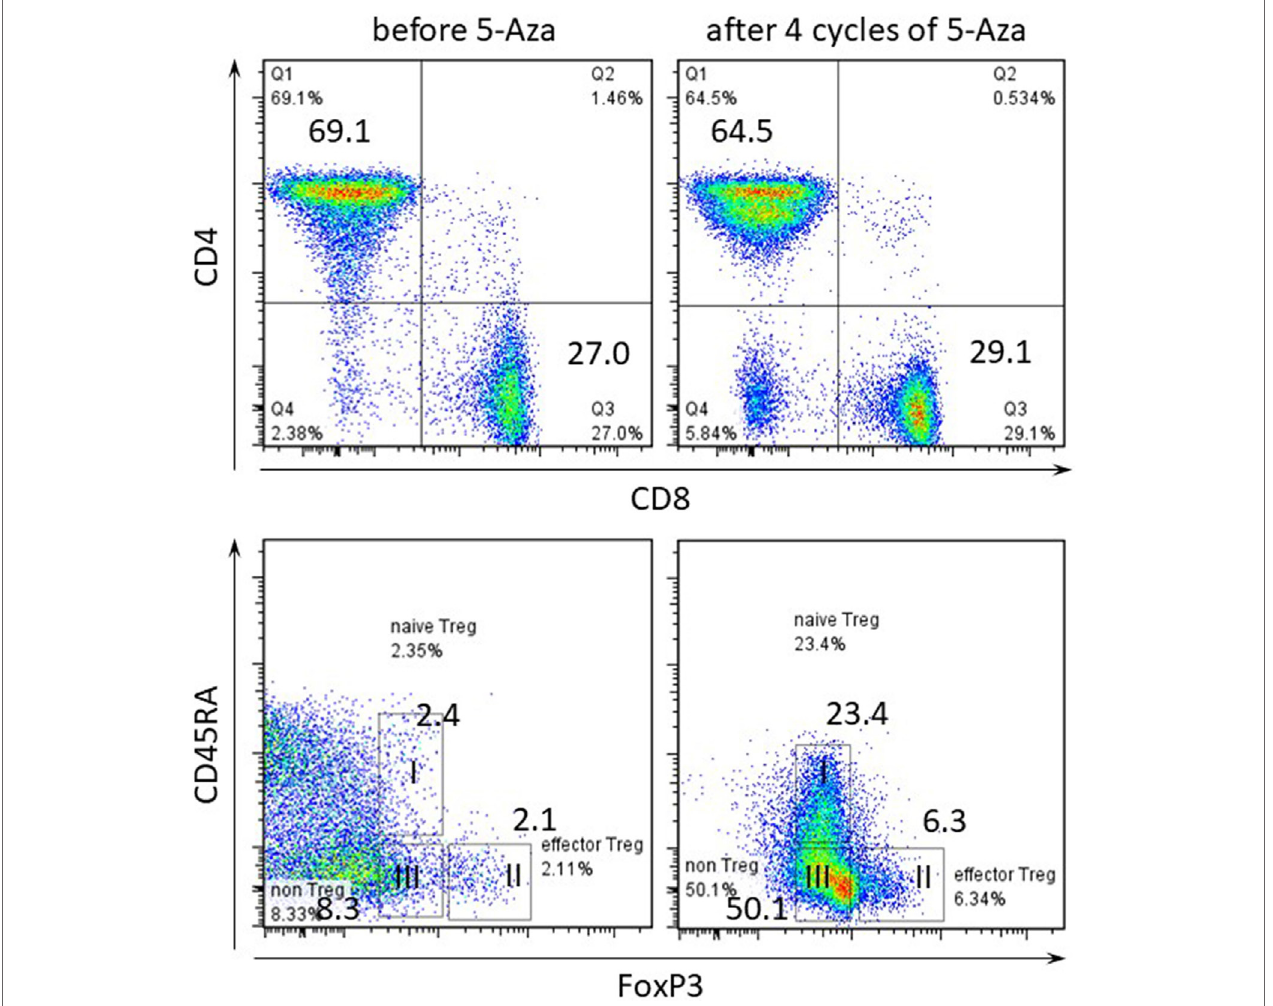
FIGURe 3 | Frequency of regulatory T cells within CD4-positive T cell compartment in peripheral blood (PB). Flow cytometry of PB gated on CD3-positive in upper panel and CD3 CD4-double positive T cells in lower panel. Numbers indicate percentage in each quadrant. I CD4 + CD45RA + forkhead box p3 (FoxP3) low naïve Treg, II CD45RA-FoxP3 high effector Treg, III CD45RA-FoxP3 low